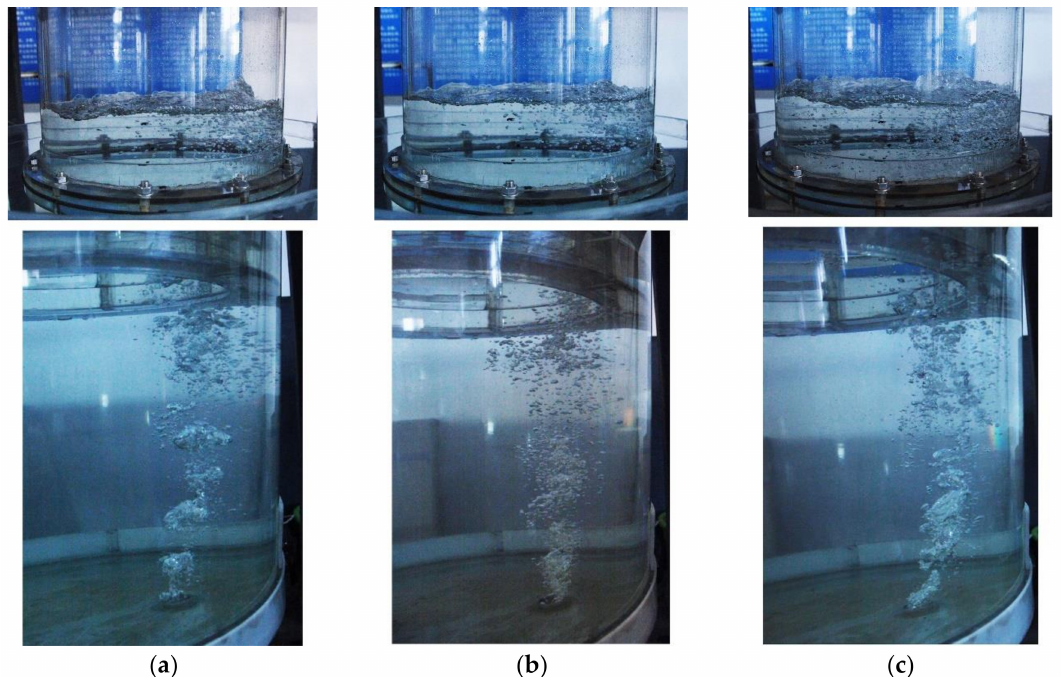
Figure 6. Picture of bubble motion in SSF water model ( a ) 360 NL/h; ( b ) 900 NL/h; ( c ) 1080